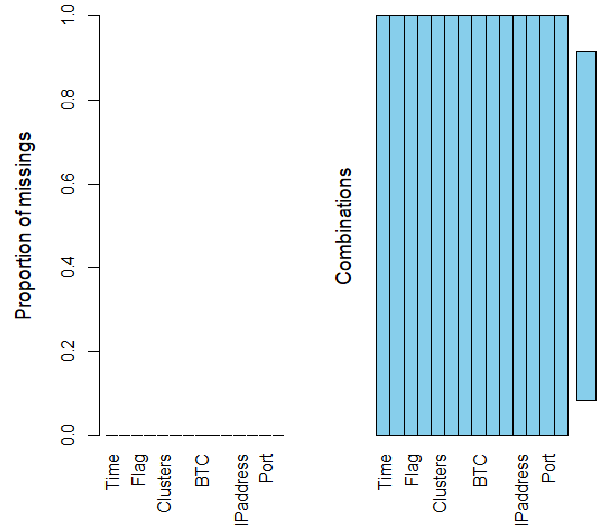
Figure 17. The cleaned UGRansome dataset with no missing